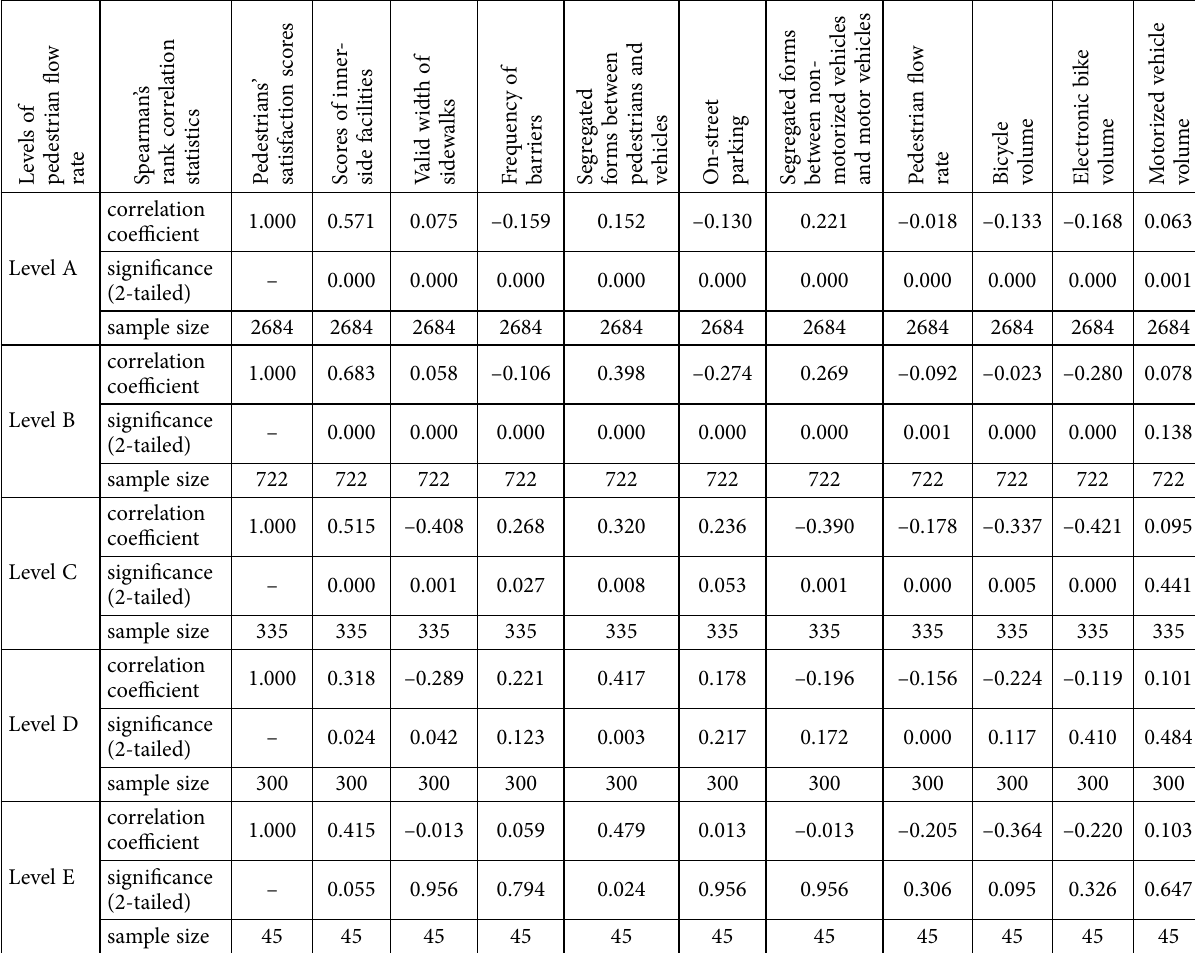
Table 5. Correlation between pedestrian satisfaction scores and each influencing factors under different pedestrian flow